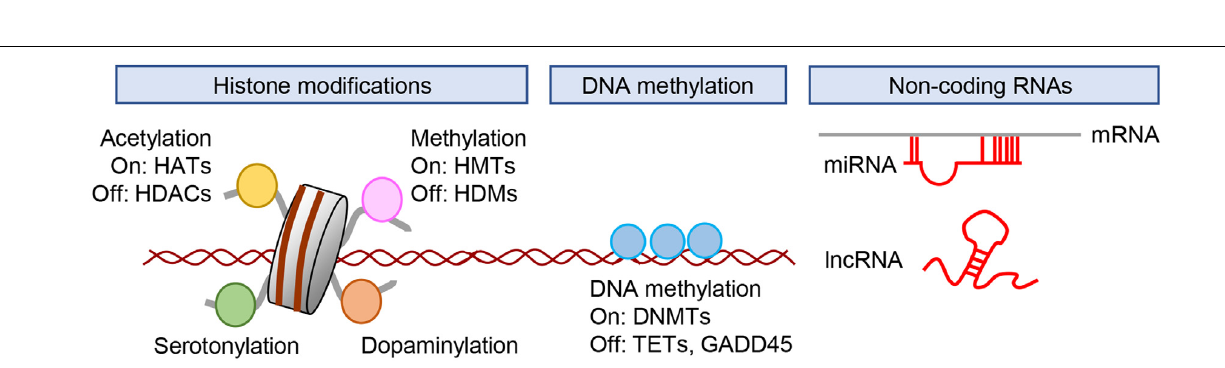
FIGURE 2 | Epigenetic regulation of gene expression. Gene expression is regulated by posttranslational modification of histones, DNA methylation, and the actions of non-coding RNAs. DNMTs; DNA methyltransferases; HATs, histone acetyltransferases; HDACs, histone deacetylases; HDMs, histone demethylases; HMTs, histone methyltransferases; lncRNA, long non-coding RNA.; miRNA, microRNA; TETs, ten-eleven